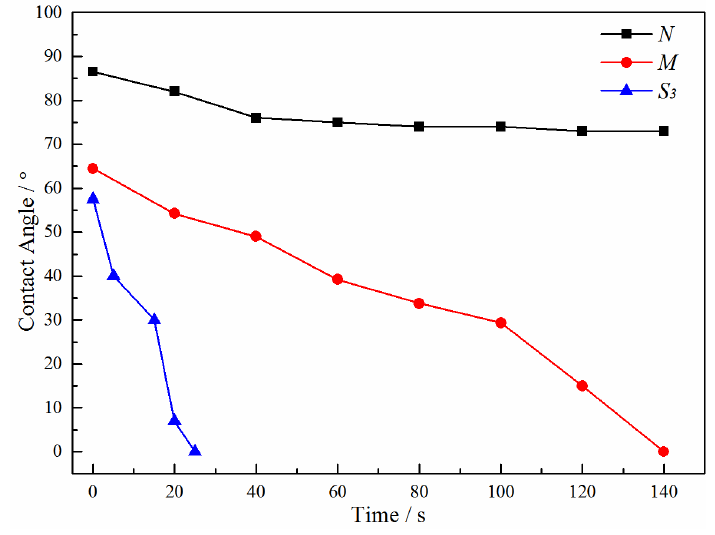
Figure 11. Dynamic water contact angles of membranes N , M and S 3 (total polymer concentration of 20 wt %).